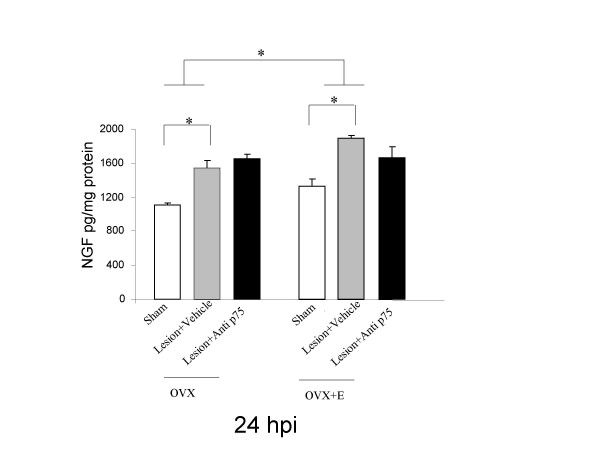
NGF regulation by lesion and estrogen treatment: Olfactory bulb lesions significantly increased NGF expression at 24 hours post injury (24 hpi). Estrogen treatment (OVX+E) increased basal and lesion-induced expression of NGF. However, anti-p75NTR had no effect on NGF expression in control pellet-replaced (OVX) or estrogen-replaced (OVX+E) animals. Bars represent means ± SEM, n = 6 per group. Sham: Sham lesion, Lesion+Vehicle: NMDA injection with pre immune serum, Lesion+Anti p75: NMDA injections with anti p75NTR antibodies. *:p < 0.05.